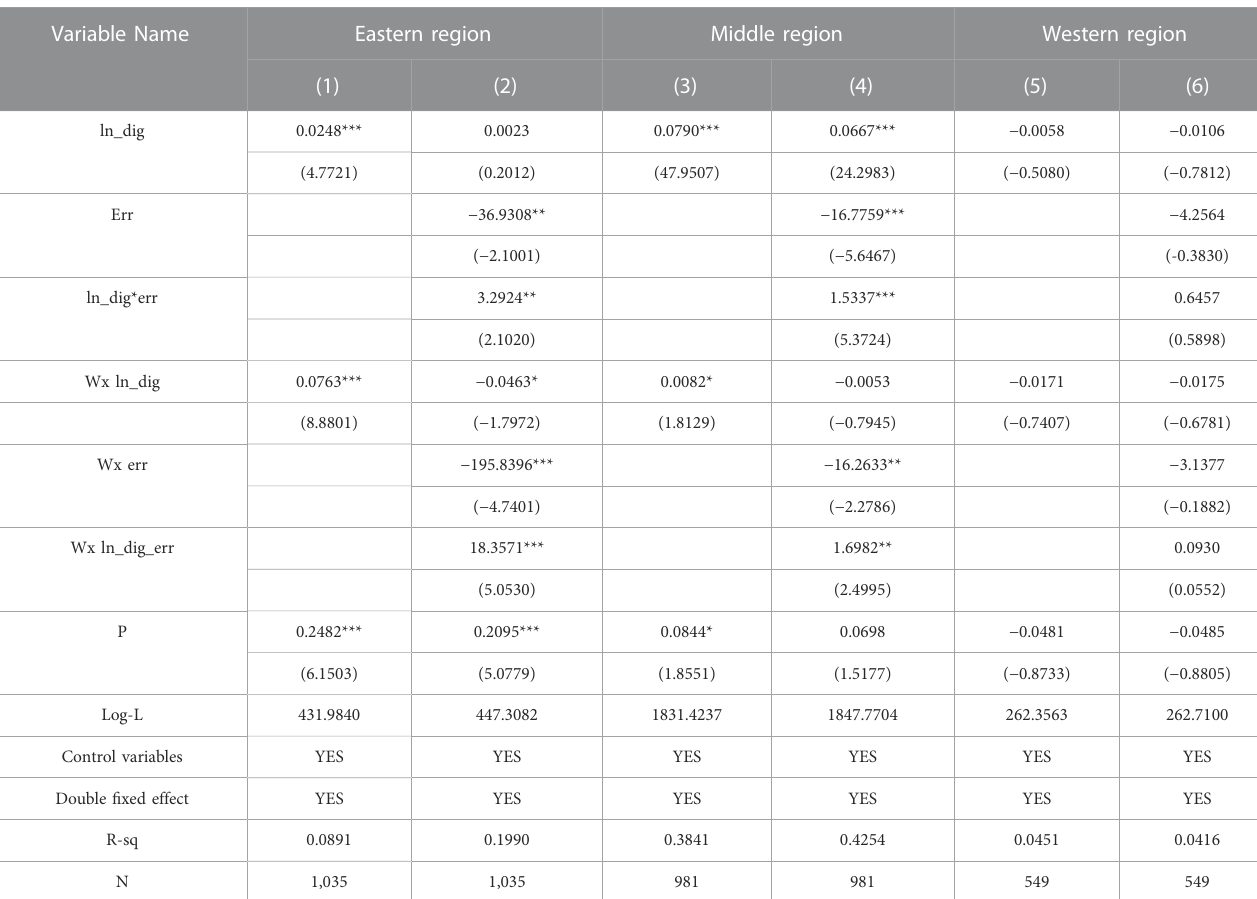
TABLE 10 Estimation results by